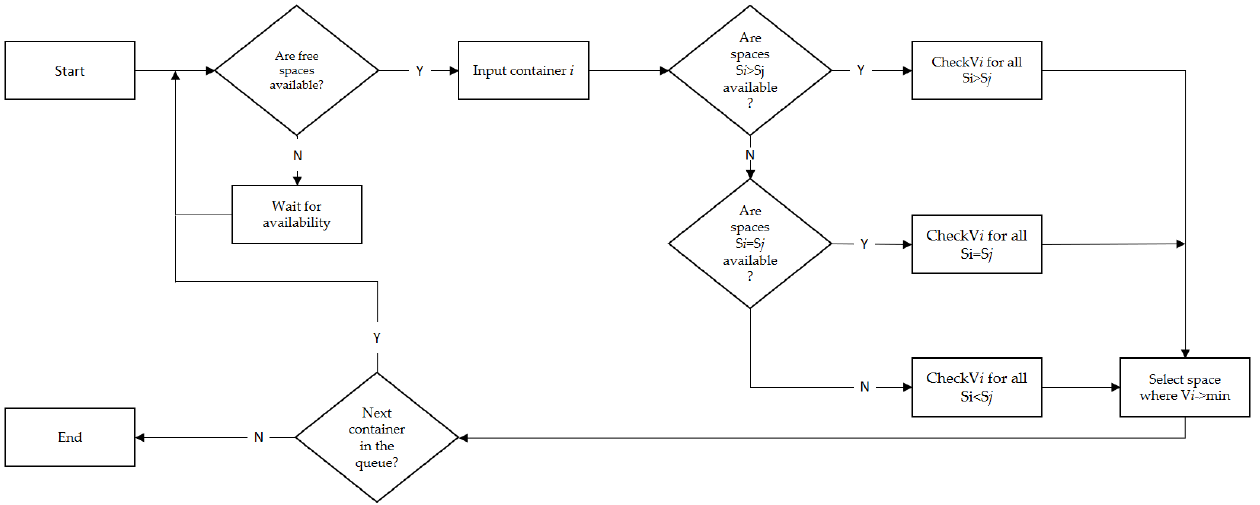
Figure 2. Model of allocating storage space at a container terminal.